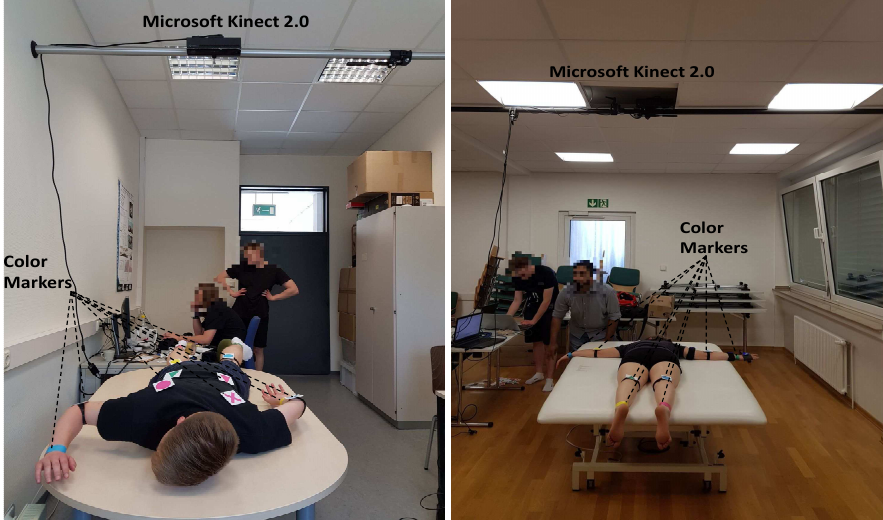
Figure 2. Camera setup during the recording in the lab ( left ) and in the hospital ( right ). The camera (Microsoft Kinect 2.0) was hooked with the help of an autopole at the height of 2 m with an angle of 90 ◦ from the table surface where the patient is lying for